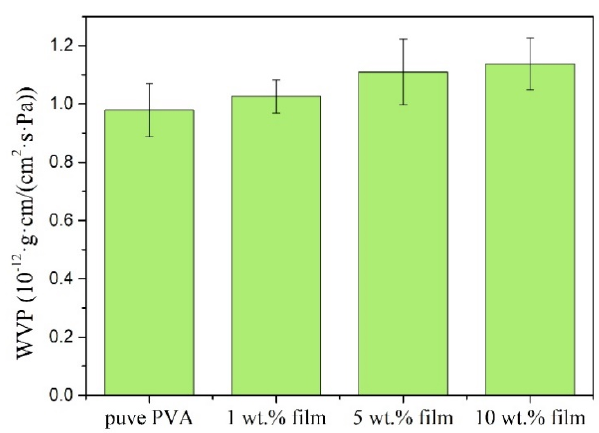
Figure 7. Water vapor permeability (WVP) of hemp / PVA composite films versus hemp loadings.